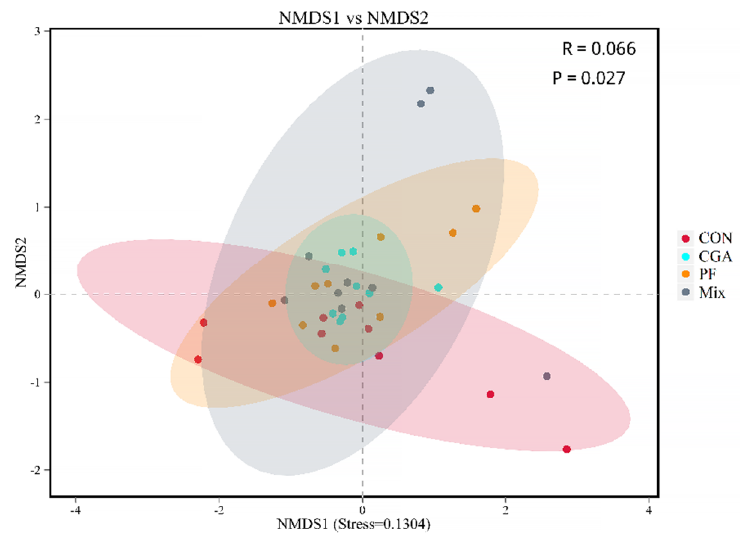
Figure 6. NMDS analysis of rectal microbes in finishing pigs.